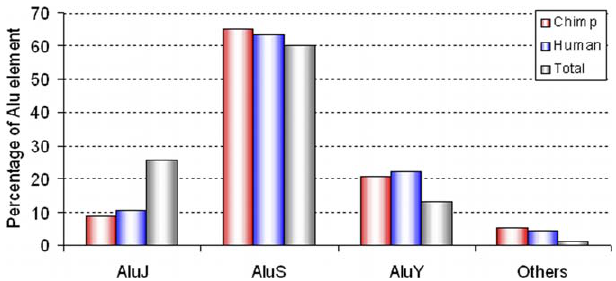
Figure 2. Alu Subfamily Composition in ARMD Events Proportion of all Alu elements involved in chimpanzee- and human- specific ARMD events (red and blue bars, respectively) that belong to each Alu subfamily as noted.